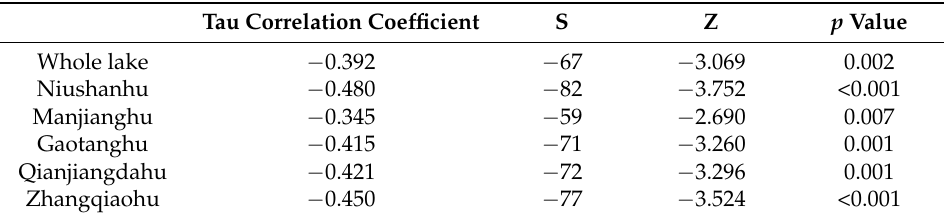
Table 3. Mann–Kendall test of water SDD variation trends in Lake Liangzi during the study period.